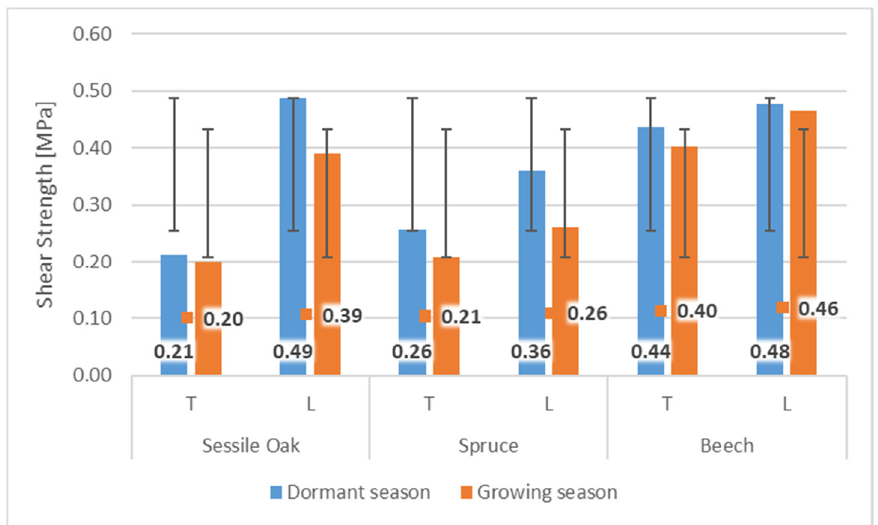
Figure 4. The values of shear strength during dormant and growing season in tangential (T) and longitudinal (L) directions for sessile oak, spruce, and beech.